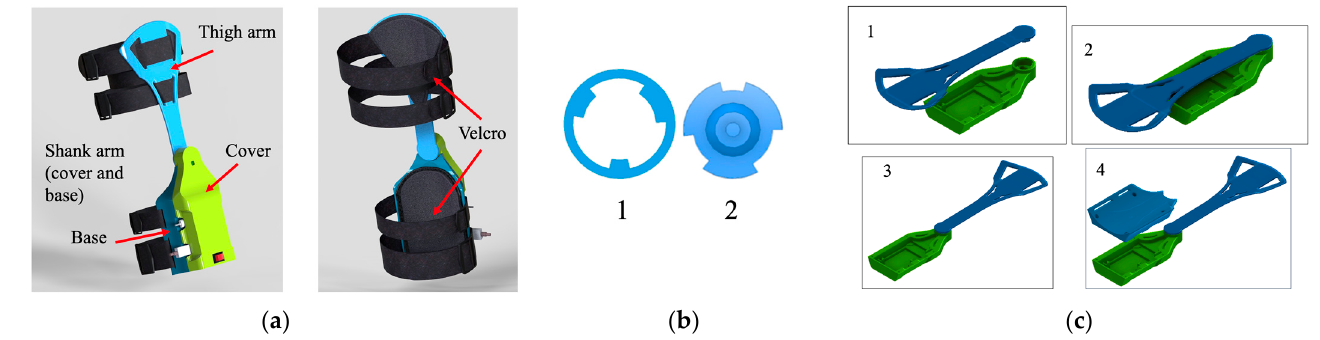
Figure 1. ( a ) CAD model of the knee wearable; ( b ) mechanical attachment pattern: 1—shank arm pattern, 2—thigh arm pattern; ( c ) assembly process of the wearable goniometer: ( 1 , 2 ) the base and the thigh arm are connected in the specific position ( 3 , 4 ) and the thigh arm is rotated 180° to allow the placement of the cover.